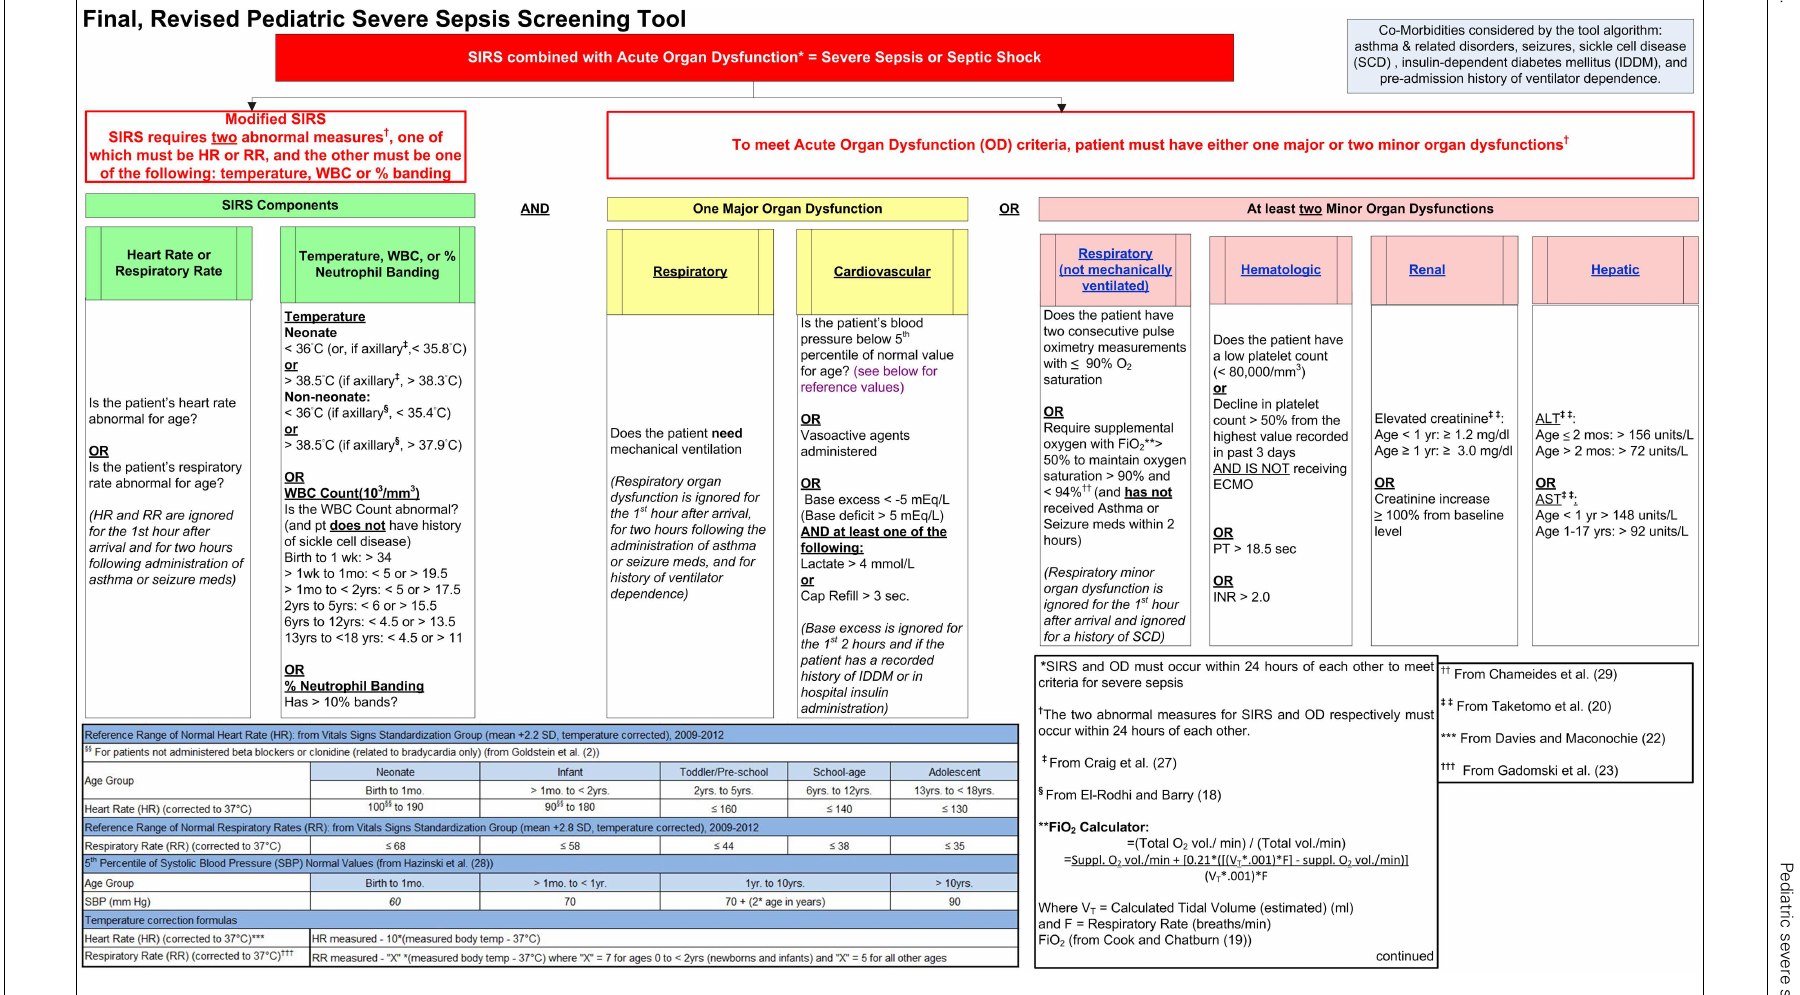
FIGURE 2 | Final, revised pediatric severe sepsis screening tool